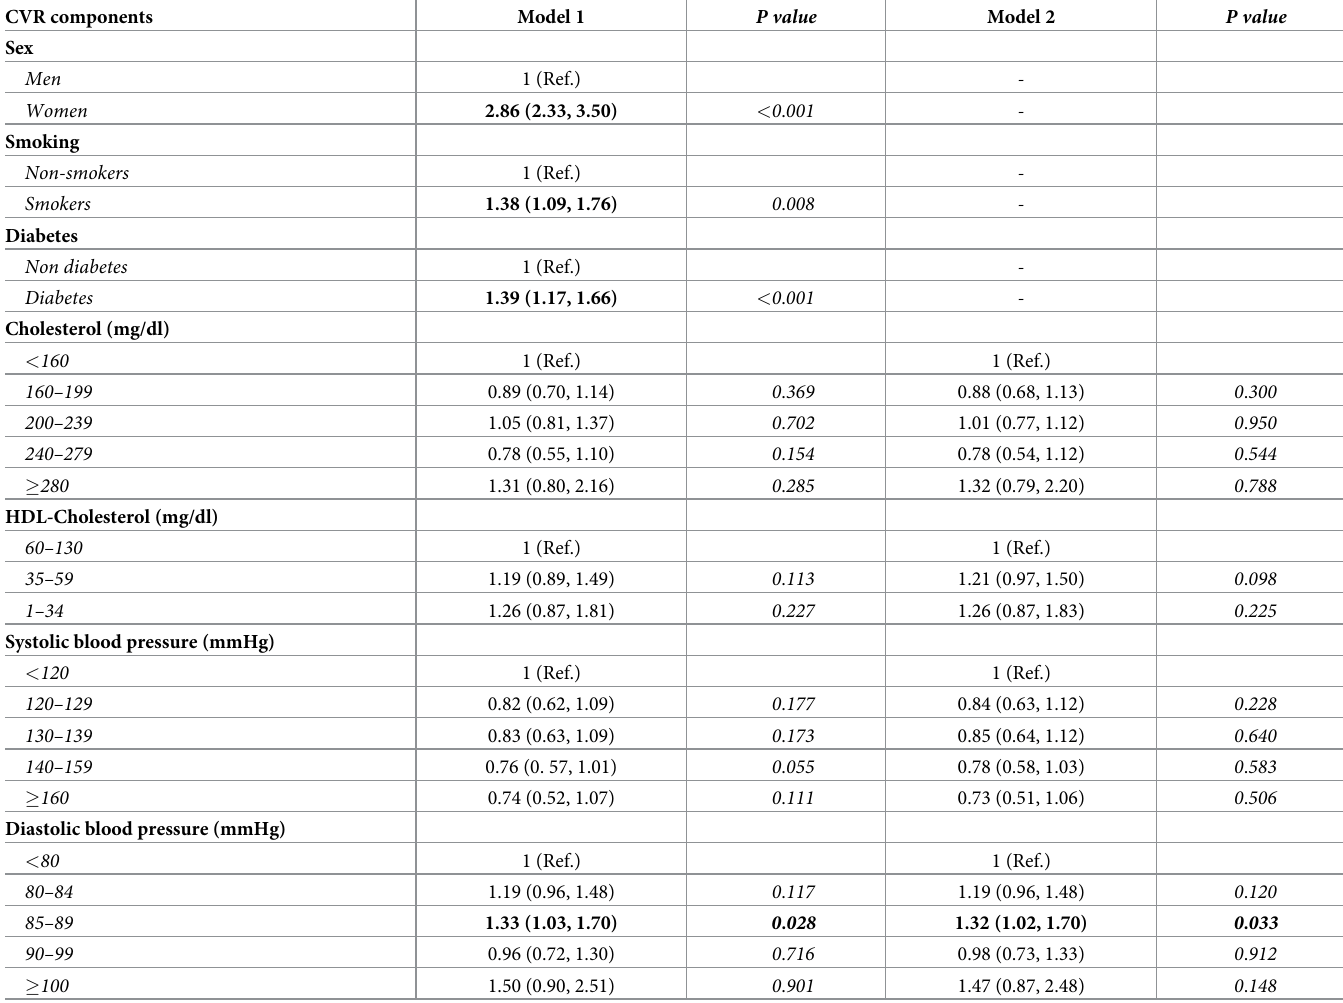
Table 2. Association between CVR components � and depressive status (BDI-II � 18) in the PREDIMED-PLUS